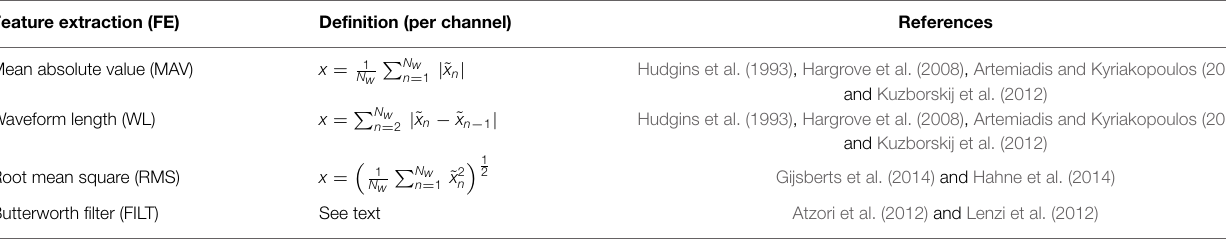
TABLE 3 | A table showing the different FEs, used on each channel of the sEMG data, analyzed in this article. Feature extraction (FE) Definition (per